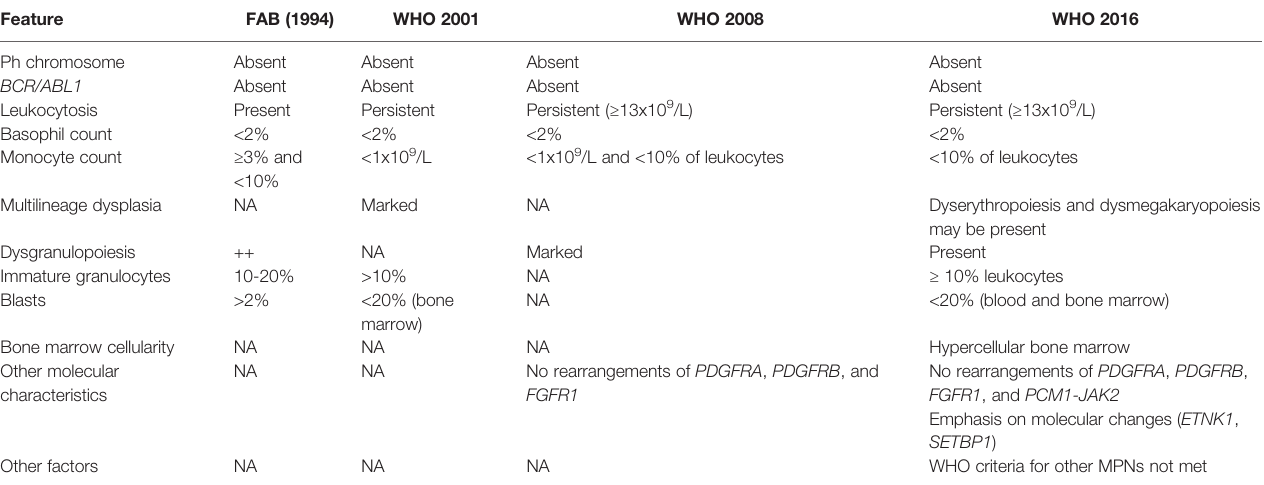
TABLE 1 | Diagnostic criteria of atypical chronic myeloid leukemia, BCR/ABL1